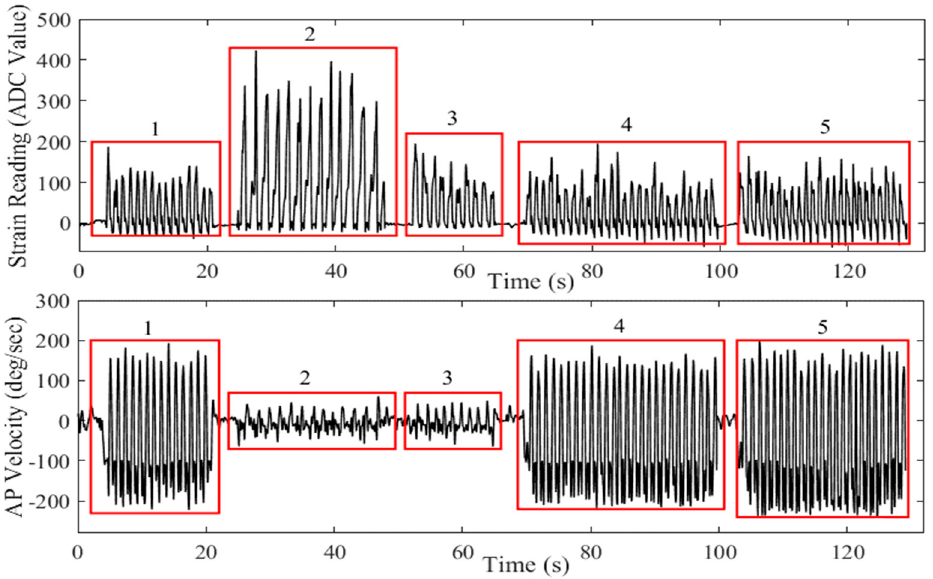
Figure 2. Strain gauge and gyroscope AP velocity readings for different walking terrains. 1—Flat surface, 2—Upstairs, 3—Downstairs, 4—Uphill, 5—Downhill.